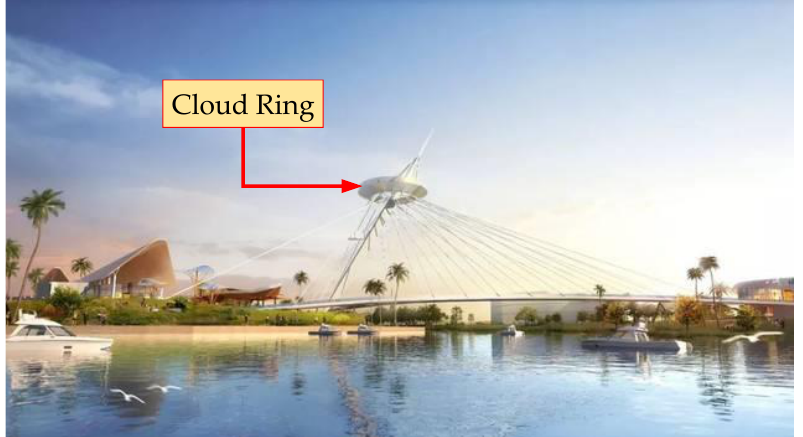
Figure 15. The Sanya Landscape Bridge.